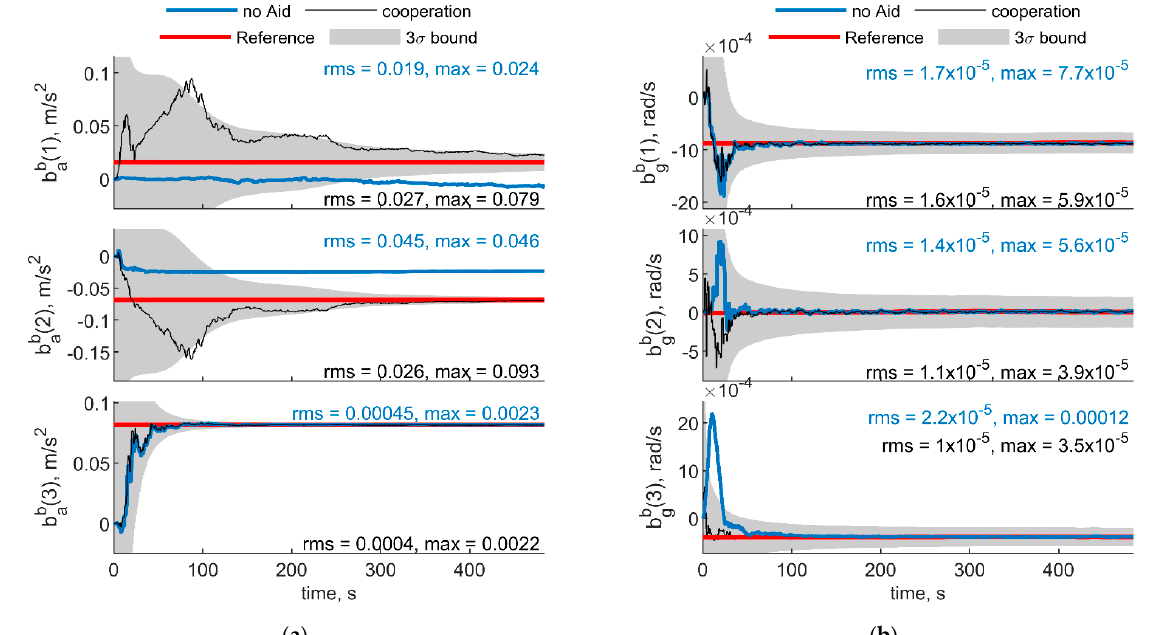
Figure 18. ( a ) Accelerometer and ( b ) gyroscope biases predicted by the filter. One deputy. Chief and deputy formation identified by case 3. Reference value is reported in red. Results obtained with cooperation and without cooperation have been reported in black and blue, respectively. RMS and maximum error value have been evaluated starting from t = 60 s.